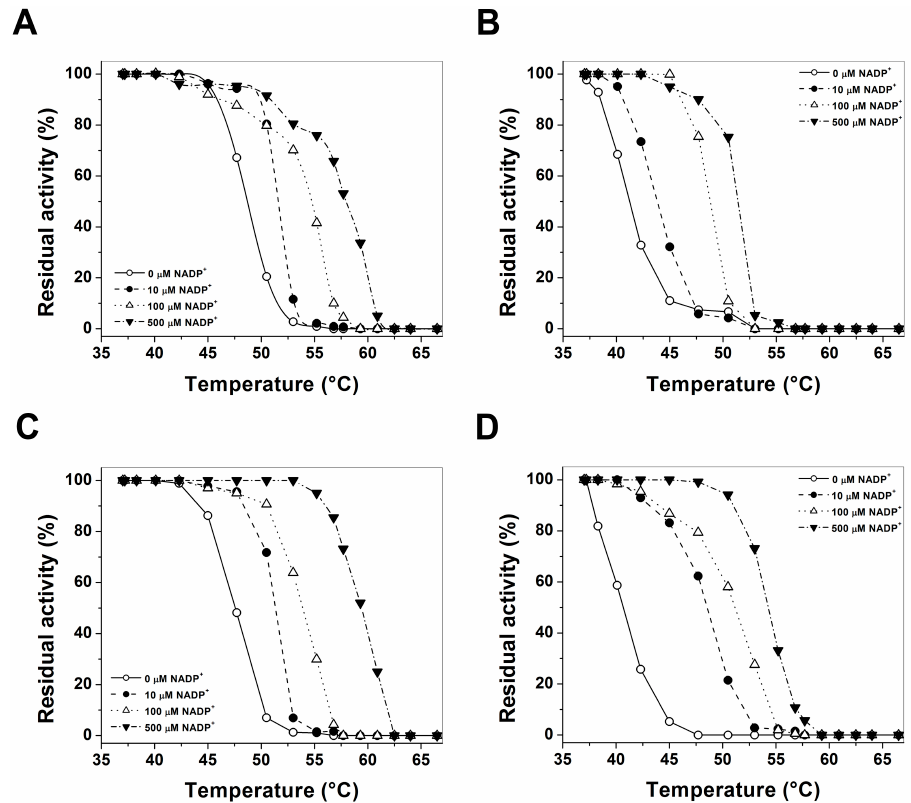
Figure 3. Thermostability assays of recombinant Wild Type glucose-6-phosphate dehydrogenase (WT G6PD) and the three mutants with different NADP + concentrations: ( A ) WT G6PD; ( B ) G6PD Zacatecas (R257L); ( C ) G6PD Vanua-Lava (L128P); and ( D ) G6PD Viangchan (V291M). In all cases, 200 ng of total protein was used. Residual activity was expressed as a percentage of the activity for the same sample incubated at 37 °C. The assays were performed in duplicate; standard errors were lower than 5%. NADP + concentrations: without NADP + ( ○ ), 10 µM (•), 100 µM ( ∆ ) and 500 µM ( ▼ ) NADP + , respectively.